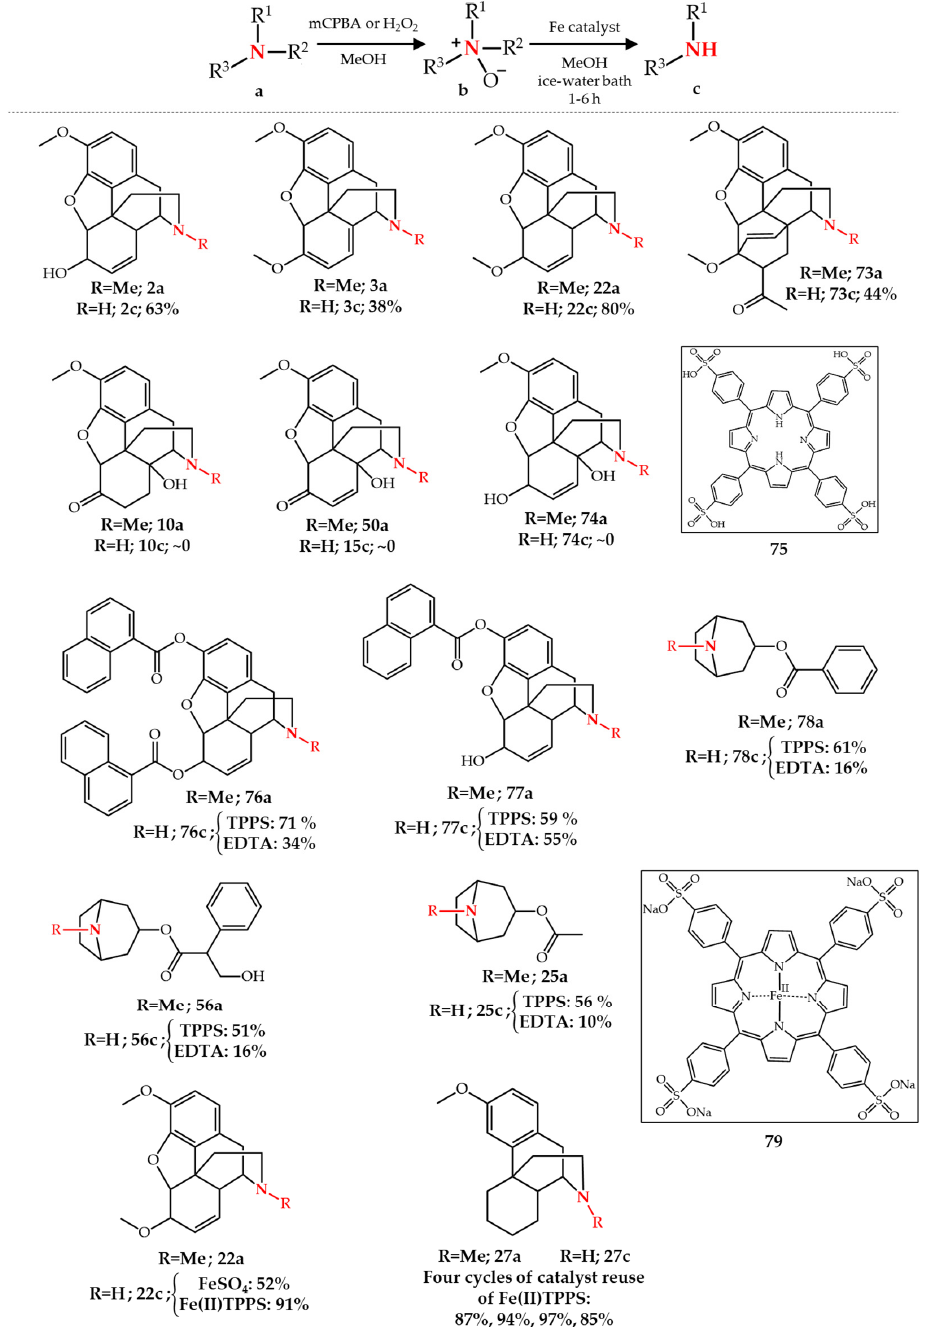
Figure 10. Fe ‐ catalyzed N ‐ demethylation of opiate and tropane alkaloids via N ‐ oxide formation. Figure 10. Fe-catalyzed N -demethylation of opiate and tropane alkaloids via N -oxide